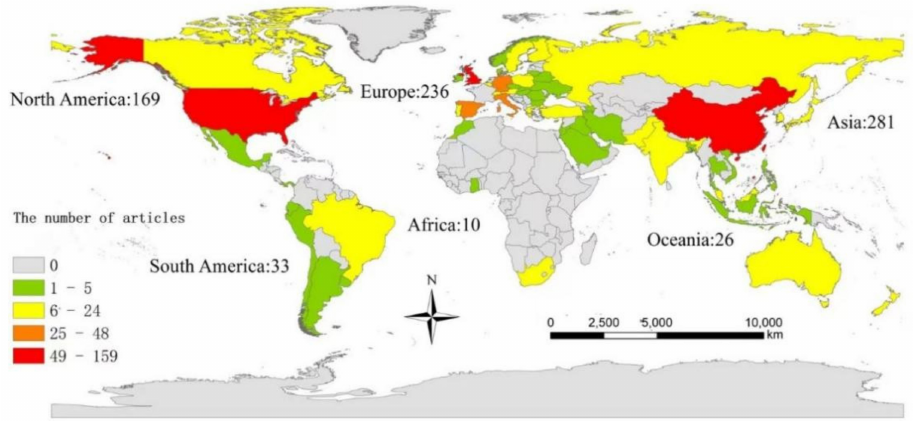
Figure 3. Spatial distribution of publications in urban park research using big